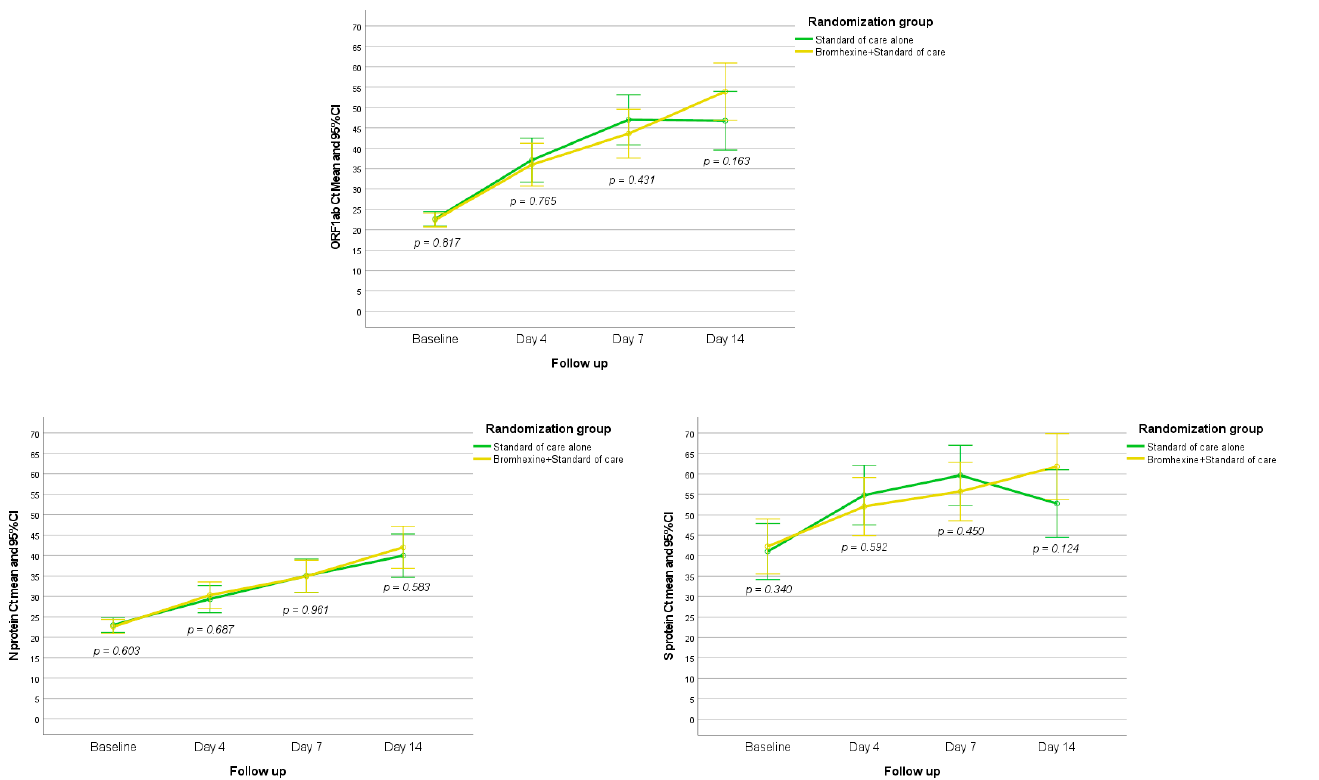
Figure 3. Evolution of Ct values of ORF1ab, N Protein, and S Protein at follow-up in the two study groups.